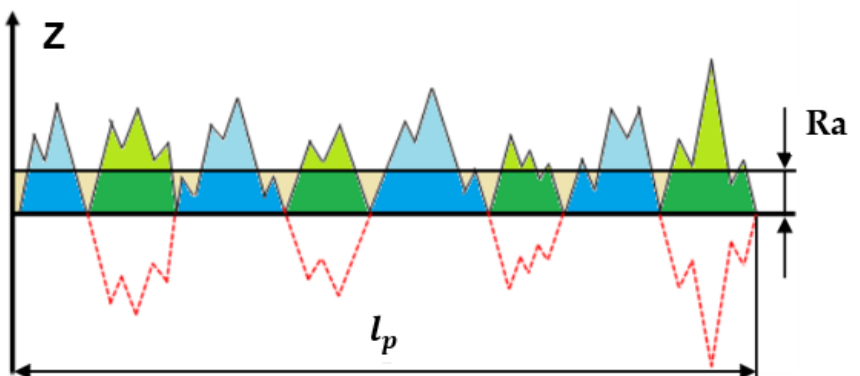
Figure 1. Geometric description of the roughness parameter Ra.